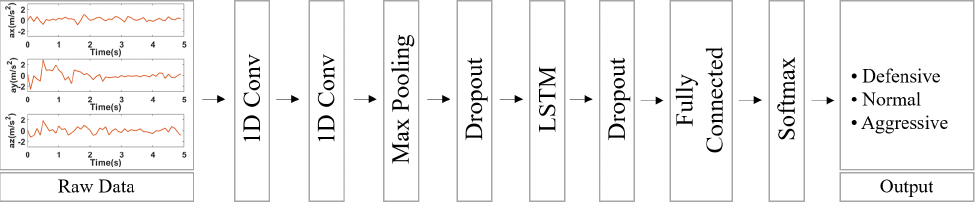
Figure 6. CNN-LSTM structure [35].